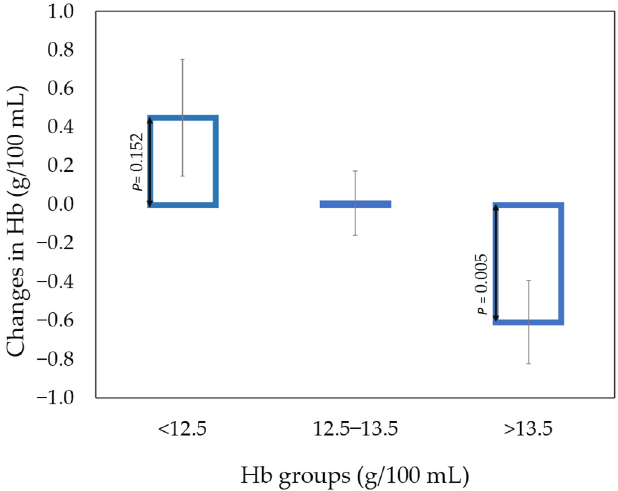
Figure 2. The figure shows the changes in the blood Hb from habitual diet to the intake of 300 g of beef per day. The changes were allocated to three Hb groups Hb according to baseline values (<12.5 mg/100 mL, 12.5–13.5 mg/100 mL, and >13.5 mg/100 mL) where the number in the three groups were 8, 14, and 12, respectively. Mean values with standard errors are given and the p-values were obtained by one-sample Z-analysis indicating probability of obtained values being larger or lower than zero.